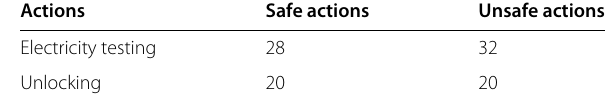
Table 3 The action types of the video